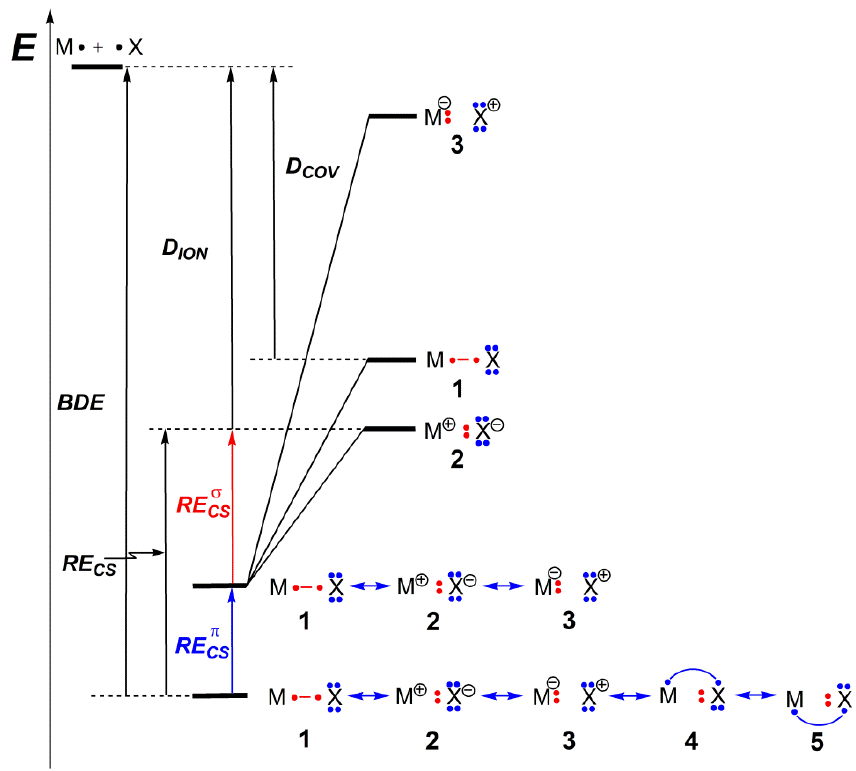
Figure 4. Schematic representation of VB interaction for MX molecules, involving the set of five VB structures displayed in Figure 1.